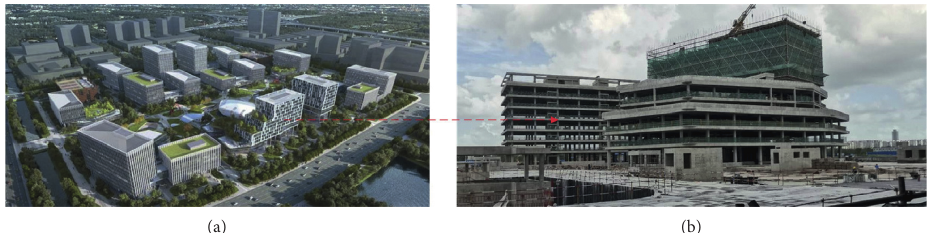
Figure 5: Some scenario information for the project case. (a) Panorama of the project. (b) Partial construction scenario of the